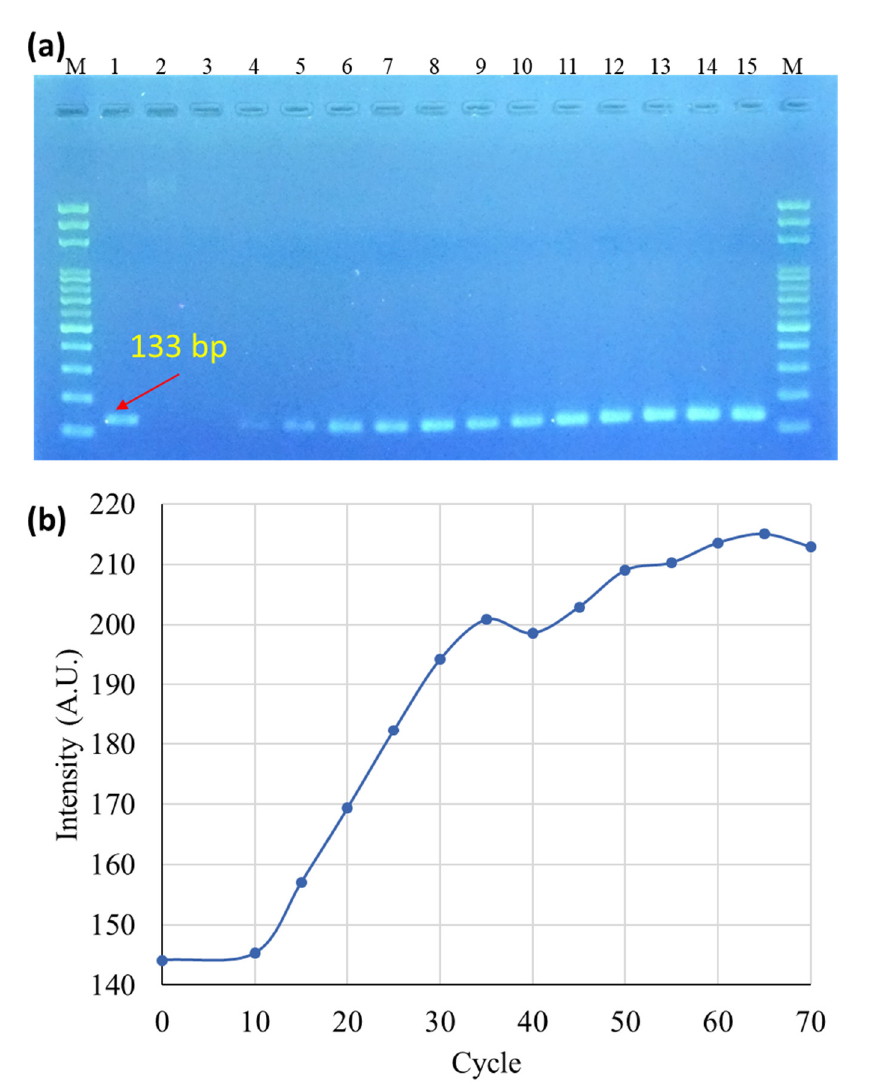
Figure 5. ( a ) Gel electrophoresis of PCR products. Lane M: 100 bp ladder marker, Lane 1: PCR product